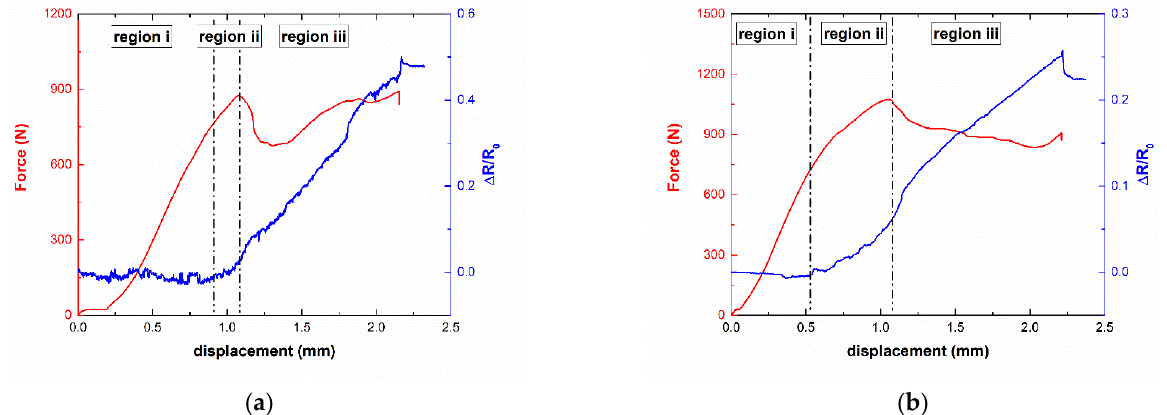
Figure 8. Electromechanical curves of ILSS ( a ) 15PCL-02CNT and ( b ) 20PCL-02CNT samples. Several differences can be observed when comparing the samples with 15 and 20 wt.%